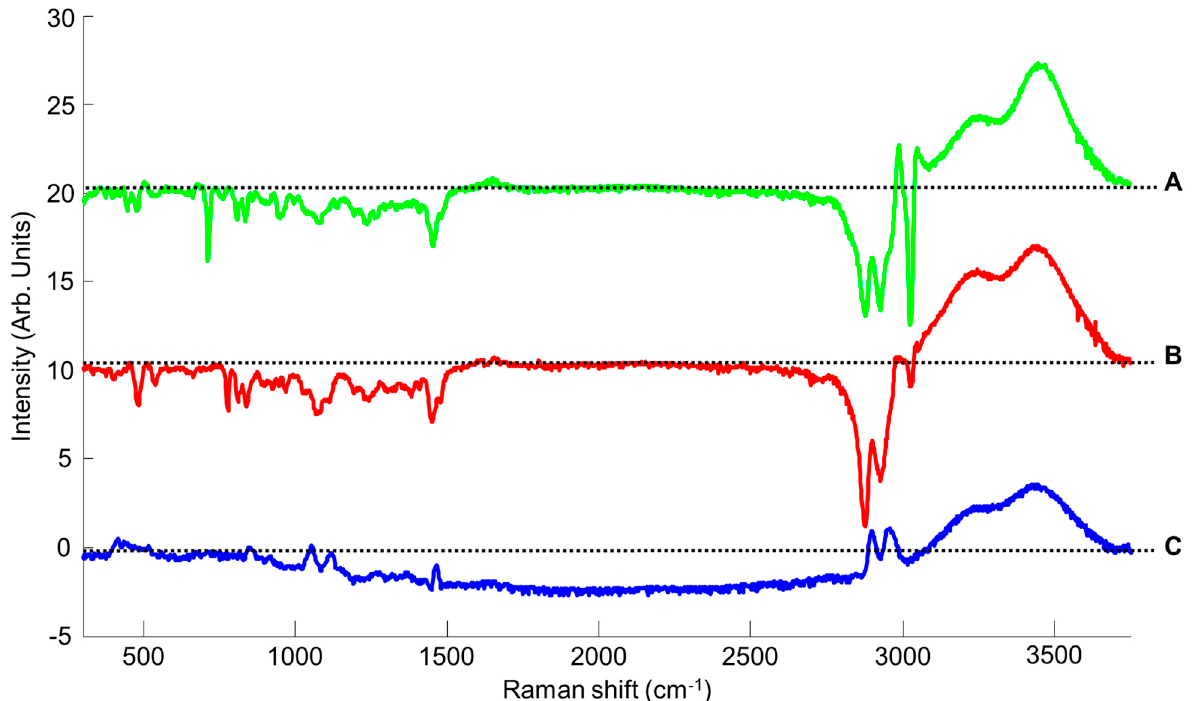
Figure 6. First regression coefficients from PLSR performed on CCG ( A ), BG ( B ) and GG ( C ) spectra. Dotted line indicates the zero baseline.